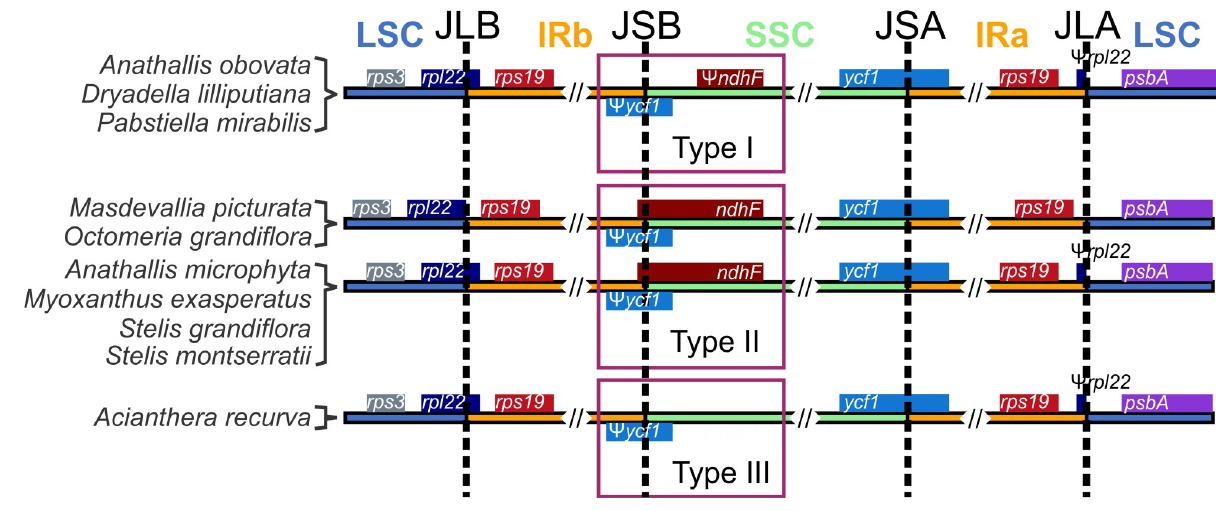
Fig 1. Inverted repeats (IRs) borders of the ten Pleurothallidinae plastomes analyzed. IRs/SSC junction types sensu Luo et al . [25].